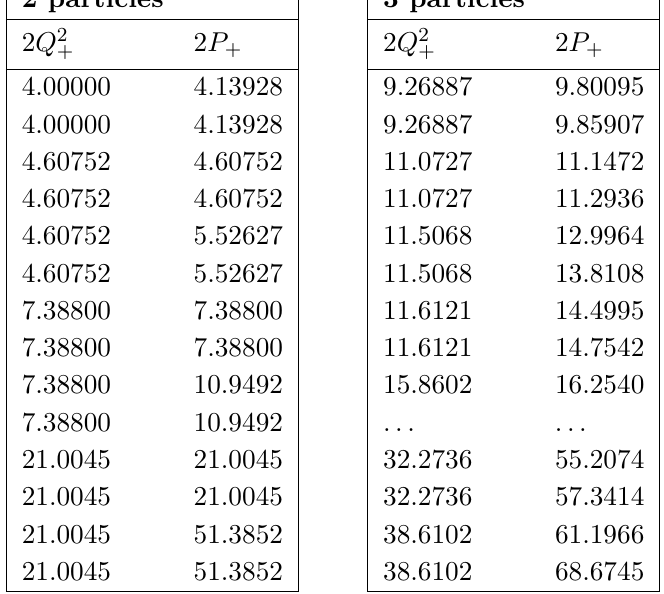
Table 2 . Mass-squared eigenvalues of the free theory in 2- and 3-particle sector, respectively, from diagonalizing Q 2 and P + in the truncated basis up to maximum degree ∆ max = 8. The truncated + basis has 14 and 28 states, respectively, in each sector. The numbers in the table are in units m 2 , where m is the mass of a single